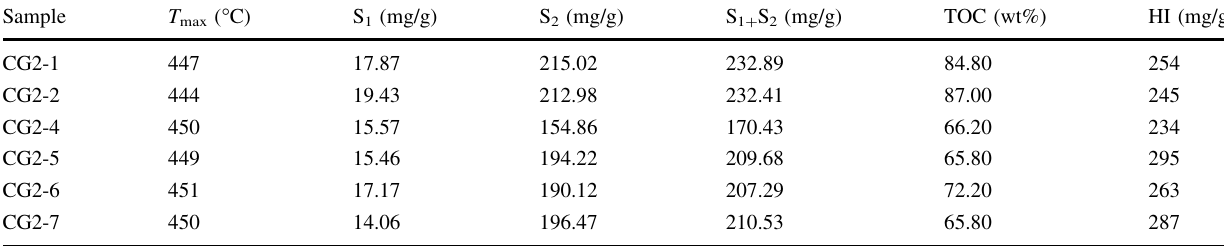
Fig. 2 The O/C and H/C correlation diagram of CG2 samples. Modified from Yang et al. (1981) Table 2 Rock-Eval parameters of the samples used